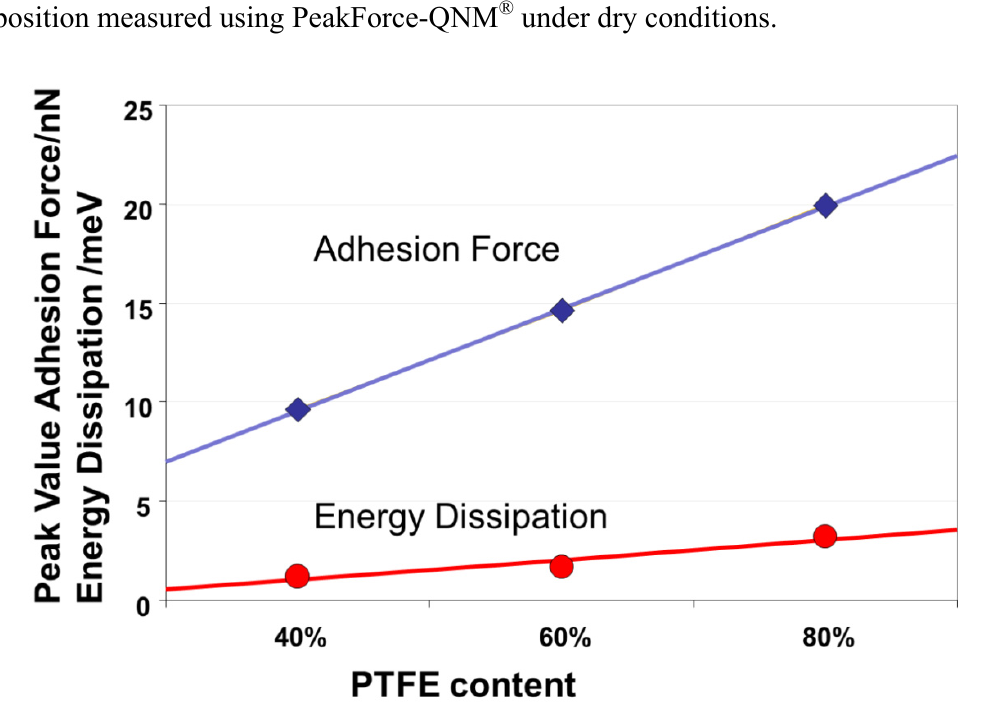
Figure 8. Dependence of adhesion force derived from samples with a known carbon/PTFE composition measured using PeakForce-QNM ® under dry